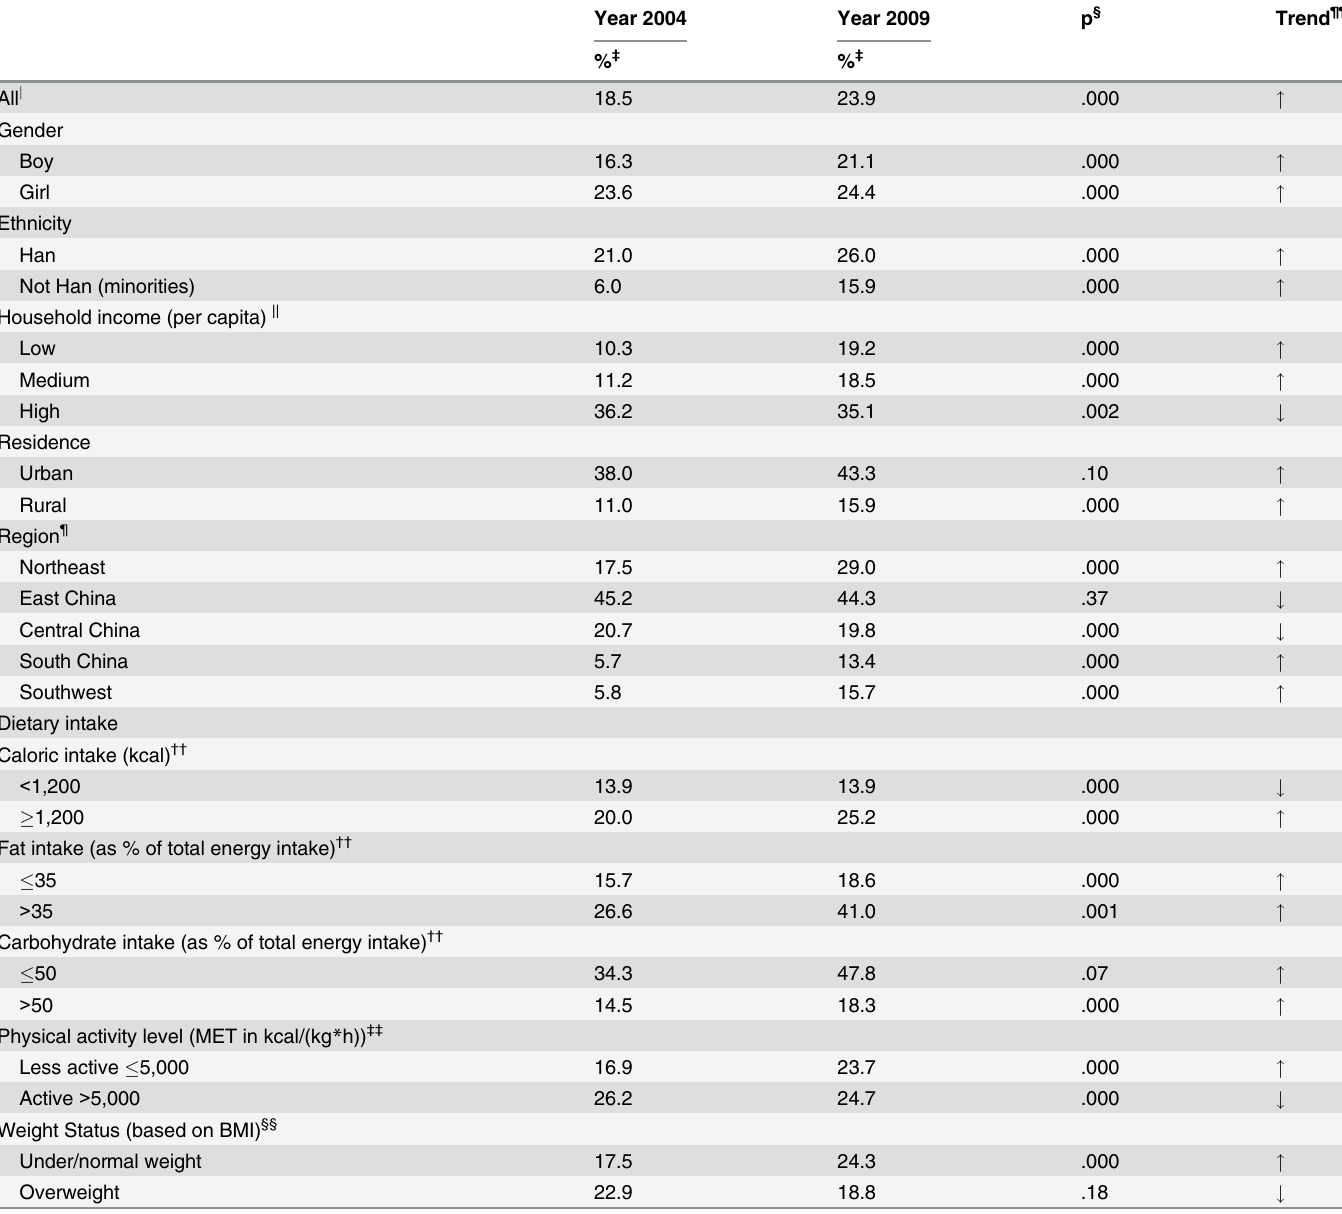
Table 2. Longitudinal analysis: Trends in the percentage (%) of Western fast food consumers among Chinese school-age children followed up from 2004 to 2009 (the same cohort, n = 376), by socio-demographics, lifestyles and weight status: China Health and Nutrition Survey 2004 – 2009 † . Year